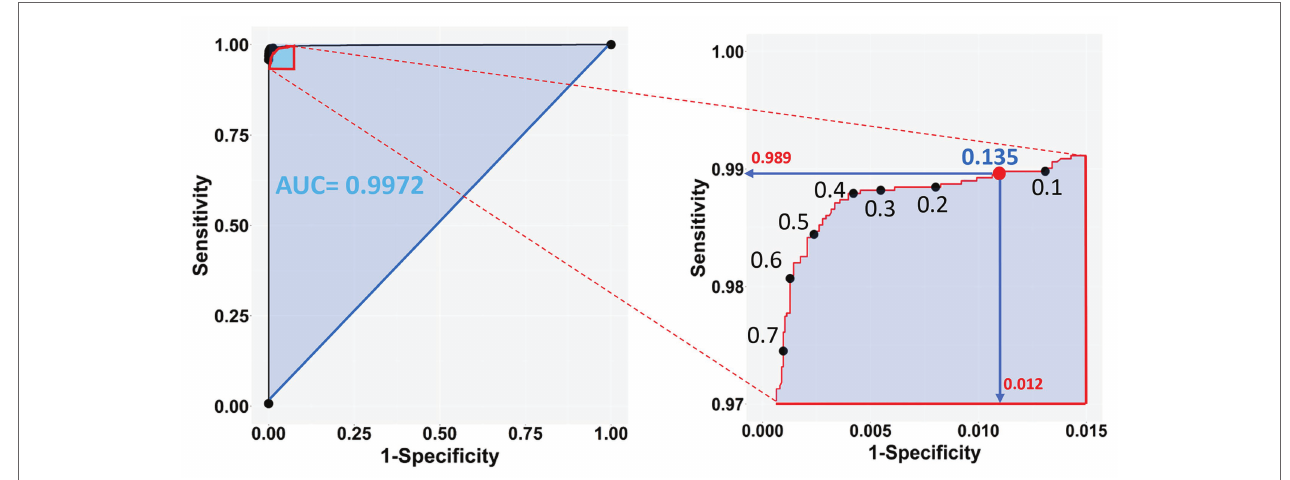
FIGURE 7 | Sensitivity vs. 1-Specificity (FP) plot of the test dataset (left panel) , zooming into the top left-hand corner of the plot region (right panel) . The blue shaded part of the plot in the left shows the Area Under the Curve (AUC). The selected cutoff of 0.135 (red dot) corresponds to a 98.9% success rate of TP and 98.8% (1 − 0.0118) TN